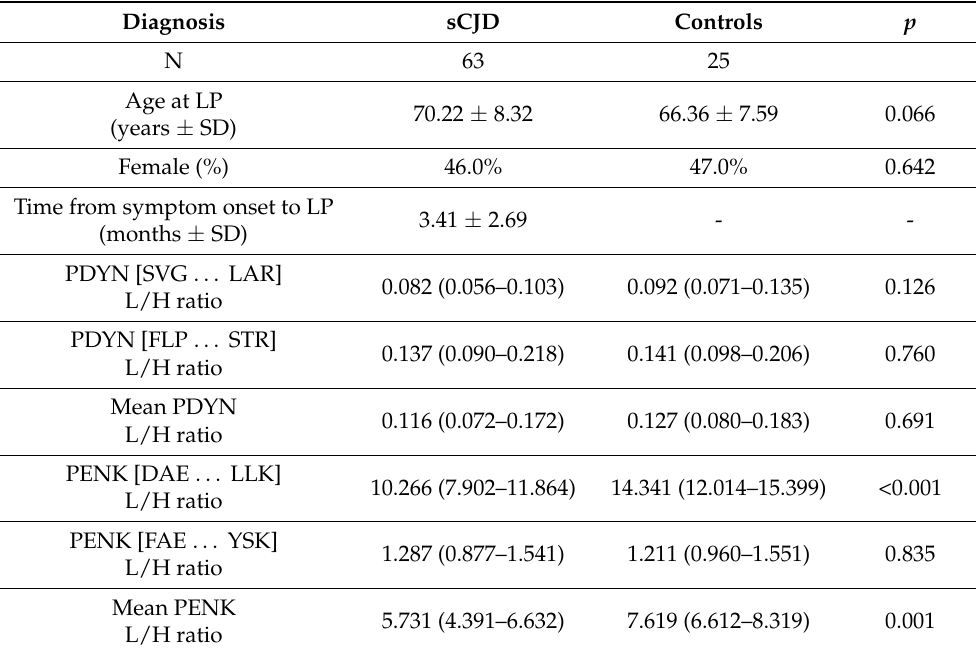
Table 1. Demographic data and PDYN and PENK levels in the diagnostic groups.